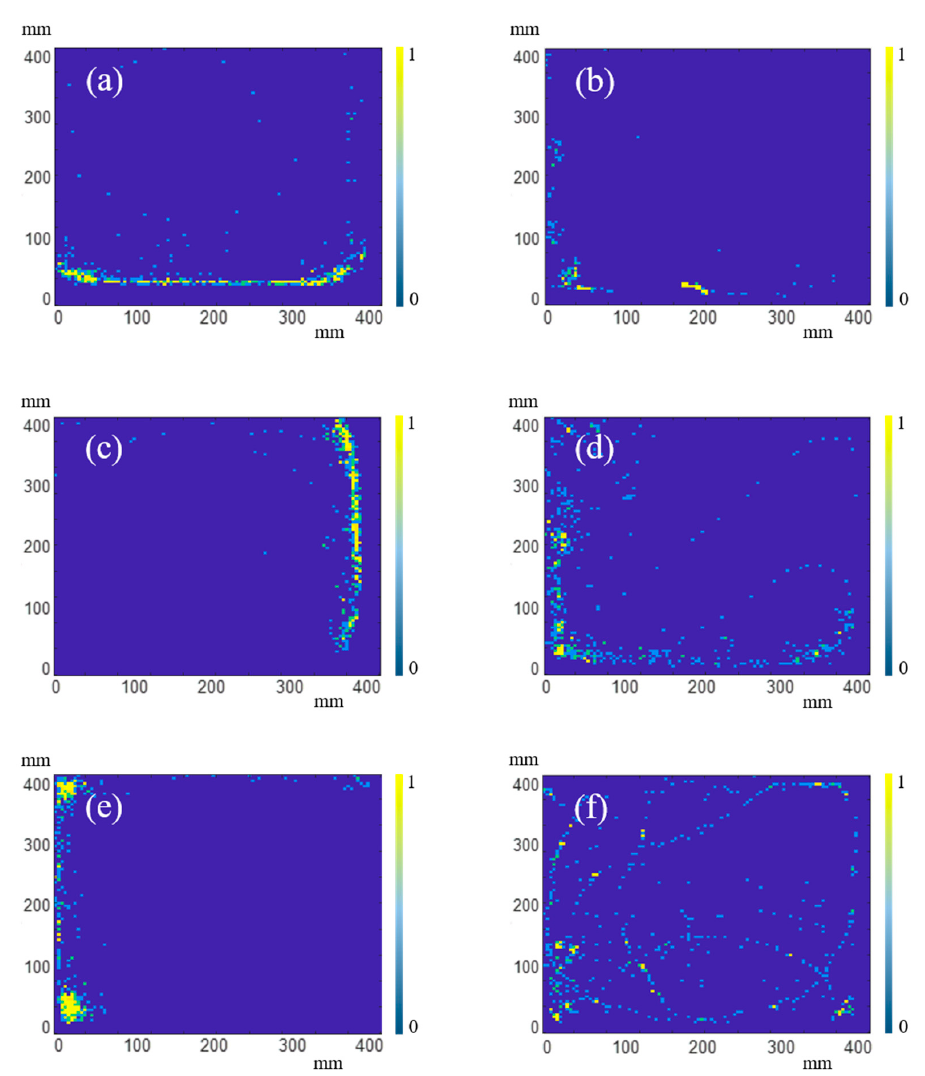
Figure 5. Thermodynamic chart of fish trajectory. ( a , b ) are under normal environment and 100 mg / L ammonium chloride environment in the first experiment, respectively; ( c , d ) are under normal environment and 200 mg / L ammonium chloride environment in the second experiment, respectively; ( e , f ) are under normal environment and 400 mg / L ammonium chloride environment in the third experiment,